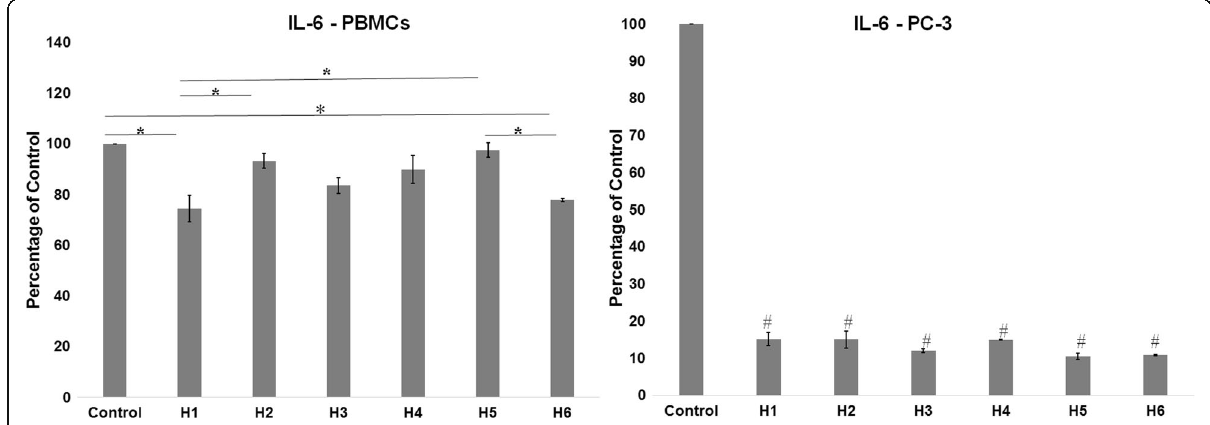
Fig. 3 IL-6 concentration after 24-h incubation with honey varieties. Data expressed as percentage of control. *Significant difference in IL-6 concentration observed between treatment groups in PBMCs. # Significant lowering of IL-6 concentration in honey treated groups compared to control in PC-3